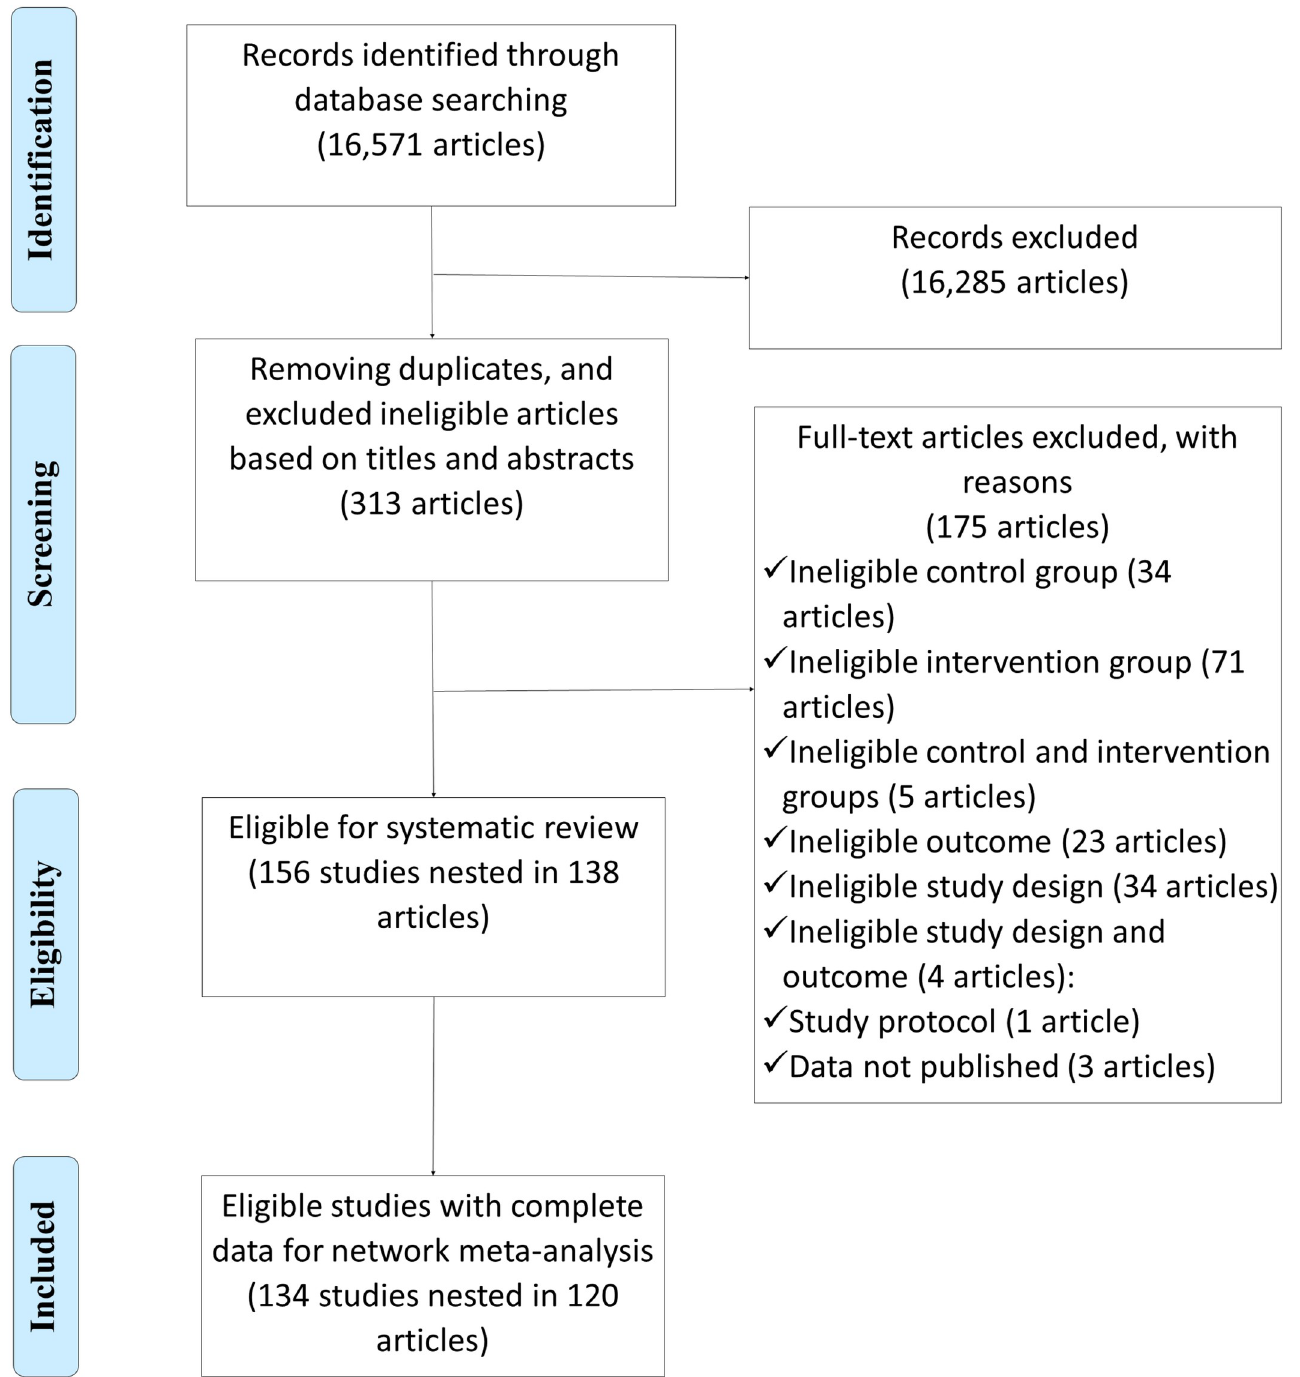
Fig 2. Flow diagram of literature searching and